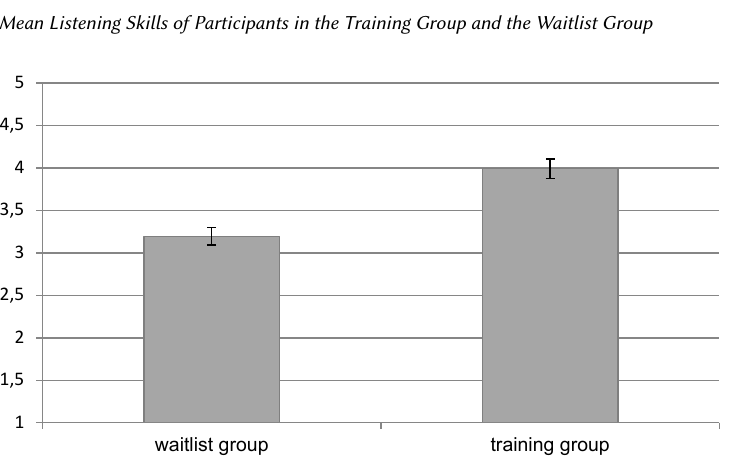
Mean Listening Skills of Participants in the Training Group and the Waitlist